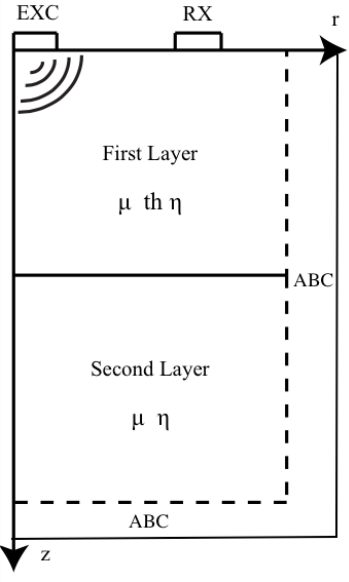
Figure 6. Two dimensional finite difference time domain